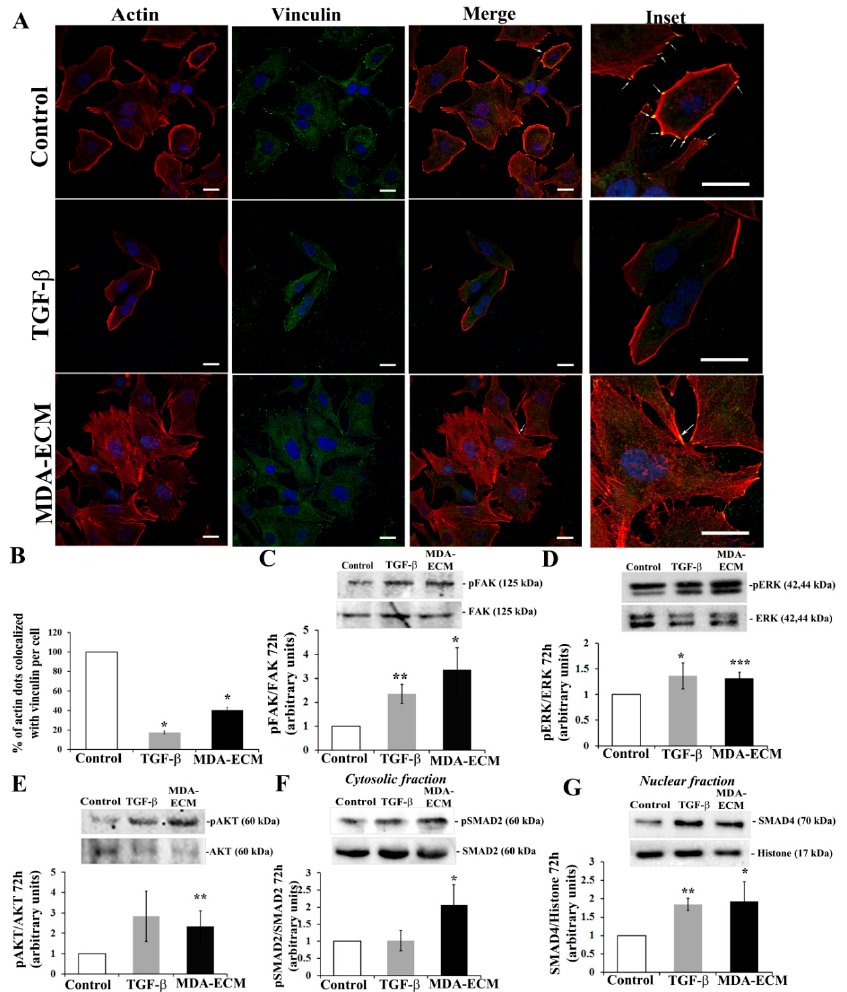
Figure 6. Interaction with MDA-ECM triggered integrin and TGF- β -associated signaling pathways in MCF-7 cells. ( A ) MCF-7 and MDA-MB-231 cells were cultured in standard conditions on coverslips for 72 h, and decellularized ECMs were obtained, as described in Methods. For double staining of F-actin and vinculin (indicated by the white asterisks), cells were marked with rhodamine-conjugated phalloidin (red) and anti-vinculin antibody (green), and nuclei were stained with DAPI. Representative images were captured at 60 × magnification. Focal adhesion assembly in control is highly visible in the section at high magnification (insets-right column). Scale bar: 20 µ m. ( B ) Representative graph showing the percentage of colocalization of vinculin and actin in comparison to the control MCF-ECM. Cell lysates were immunoblotted with ( C ) anti-pFAK Tyr397 and anti-FAK, ( D ) anti-pERK1 / 2 and anti-ERK1 / 2, ( E ) anti-pAKT Ser473 and anti-AKT, ( F ) anti-pSMAD2 and anti-SMAD2, and ( G ) anti-SMAD 4 and anti-histone (H3) antibodies. The results are shown as the fold increase compared to the MCF-ECM group, calculated from 3 individual experiments (* p < 0.05; ** p < 0.01; *** p <